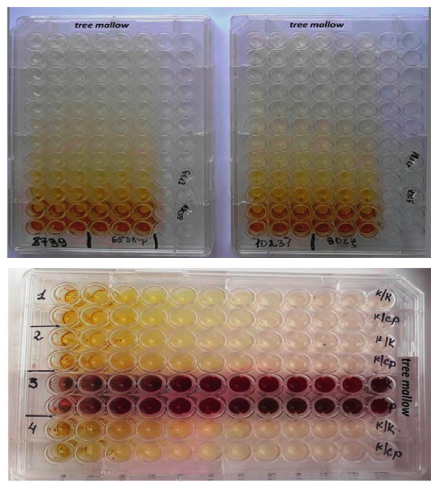
Figure 1: Setting antimicrobial activity in a 96-well